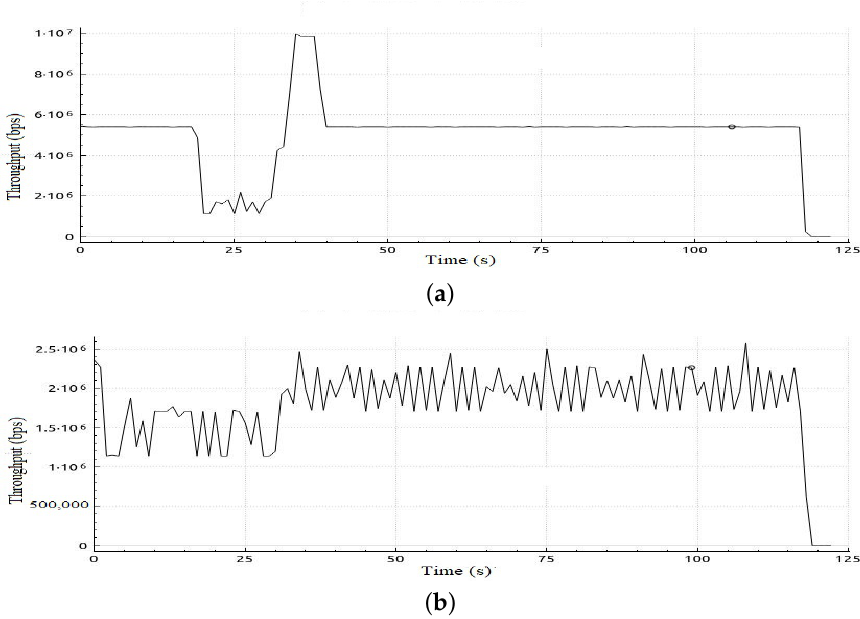
Figure 10. Throughput obtained in Scenario 1 in case of applying and without applying the proposed adaptive QoS model for 120-s BE traffic flow ( a ) Throughput obtained in Scenario 1 in case of applying the proposed adaptive QoS model, ( b ) Throughput obtained in Scenario 1 without applying the proposed adaptive QoS